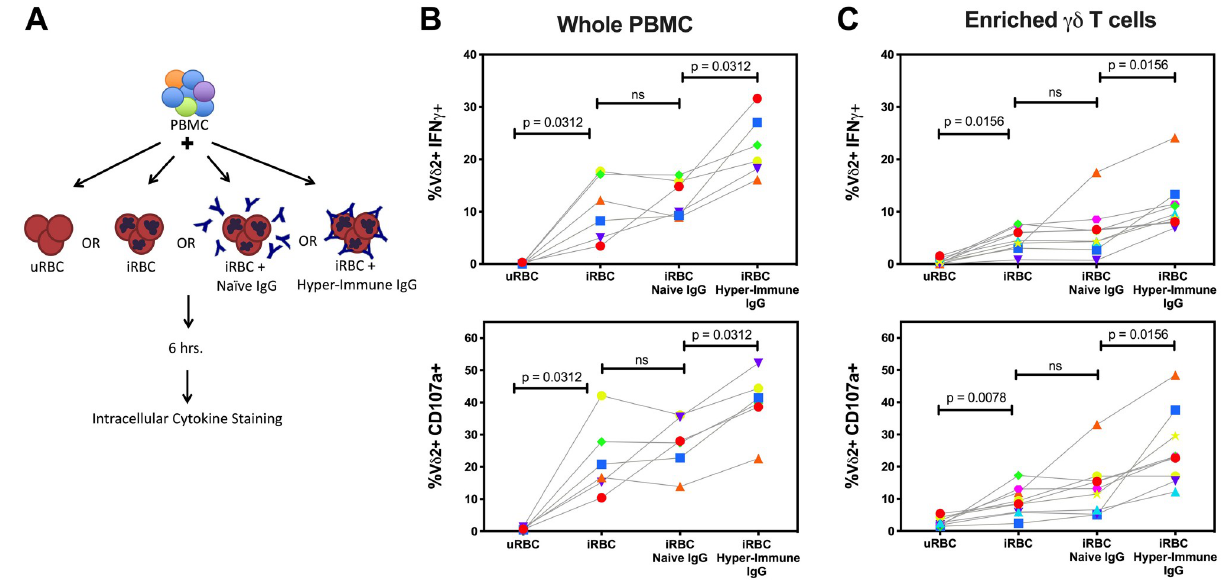
Fig 4. Stimulation by opsonized antigen augments V δ 2 cell activation by P . falciparum . (A) Schematic detailing the stimulation conditions for data presented in panel B. (B) Percent of V δ 2 T cells positive for IFN γ and CD107a after stimulation of whole PBMC with uRBC, iRBC, iRBC + na ï ve IgG, or iRBC + hyper-immune IgG. (n = 6). (C) Percent of V δ 2 T cells positive for IFN γ and CD107a after stimulation of negatively selected γδ T cells with uRBC, iRBC, iRBC + na ï ve IgG, or iRBC + hyper-immune IgG. (n = 9). All V δ 2+ T cells shown were gated on singlets and CD3+ events to exclude NK cells. Samples for this experiment were selected from individuals with greater than 30% of their V δ 2 T cells expressing CD16. P values were determined by Wilcoxon matched pairs signed rank test.